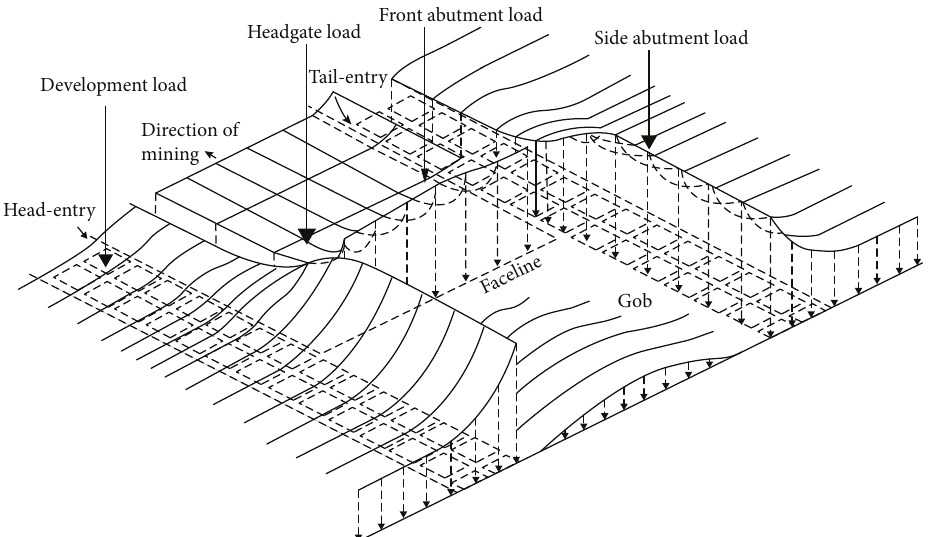
Figure 2: The schematic layout of the stress redistribution around a longwall mining panel